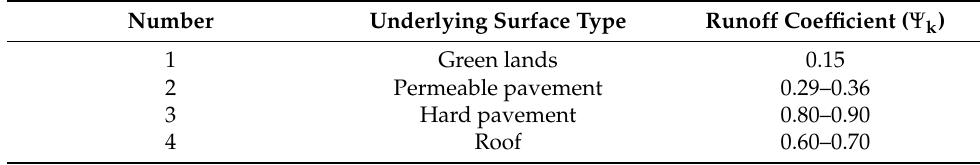
Table 2. Runoff coefficient for each underlying